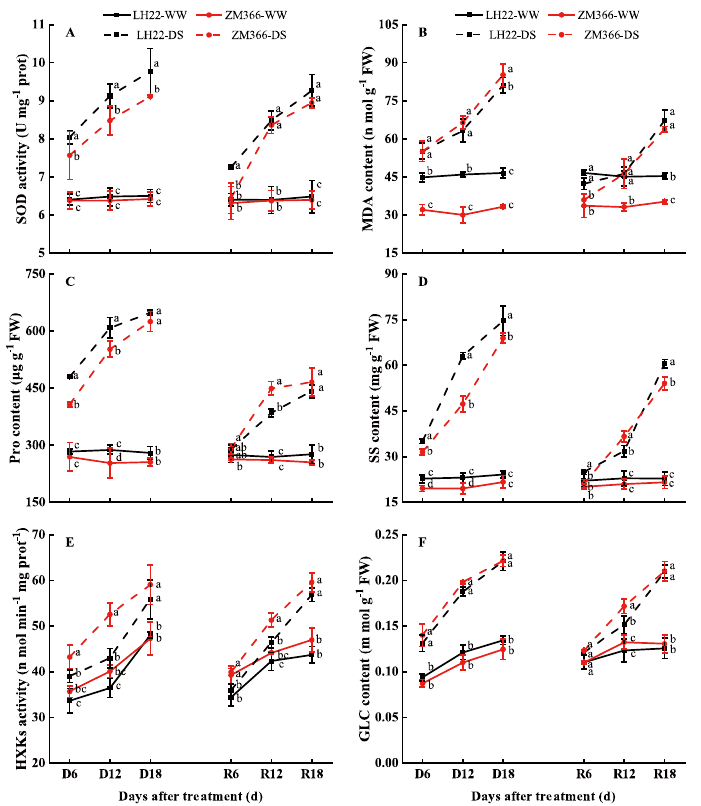
Figure 3. Effects of drought − re-watering on ( A ) superoxide dismutase (SOD), ( B ) malondialdehyde (MDA), ( C ) Proline (Pro), ( D ) soluble sugar (SS), ( E ) hexokinase activity (HXKs), and ( F ) glucose content (GLC) in the flag leaves of wheat at the booting stage. WW: well − watered; DS: drought stress; D 6, D 12, and D 18 indicate 6 d, 12 d, and 18 d of stress, respectively. R 6, R 12, and R 18 indicate re-watering after 6 d, 12 d, and 18 d of stress, respectively. Different lowercase letters in the same column indicate significant differences between the treatments (LH 22 − WW, ZM 366 − WW, LH 22 − DS, and ZM 366 − DS) at p < 0.05 (Duncan).